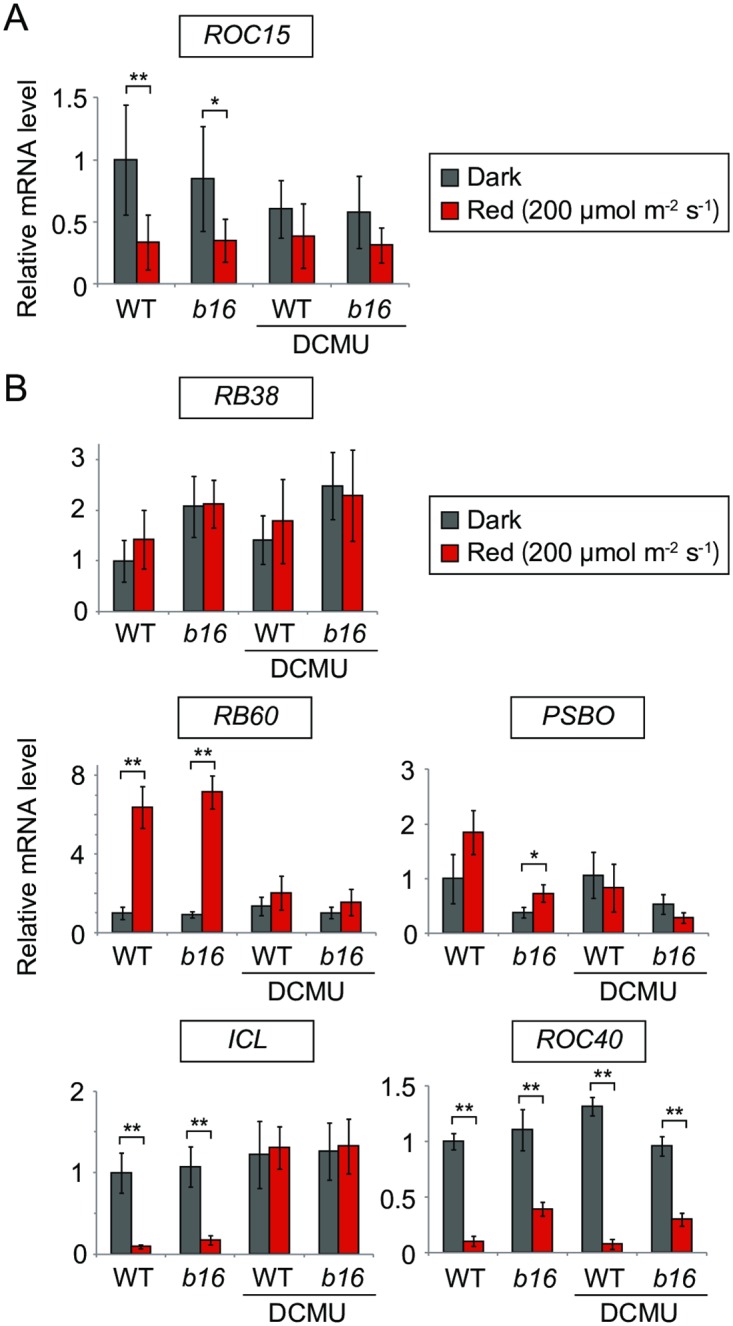
Red light response of ROC15 and other mRNAs.Early log phase TAP liquid cultures (approximately 5 x 105 cells/mL) of WT and b16 were adapted to darkness for one day, and then exposed to red light (200 μmol∙m-2∙s-1) for 2 h. DCMU was added to the cultures before dark adaptation at a final concentration of 10 μM. (A, B) RT-qPCR result of ROC15 (A) and other genes (B). Graphs represent the mean ± SD of 3–6 independent experiments. The transcript abundances relative to RCK1 were further normalized by dividing by the average for the dark control of the WT for easy comparison. * P < 0.05, ** P < 0.01 (Student’s t-test).